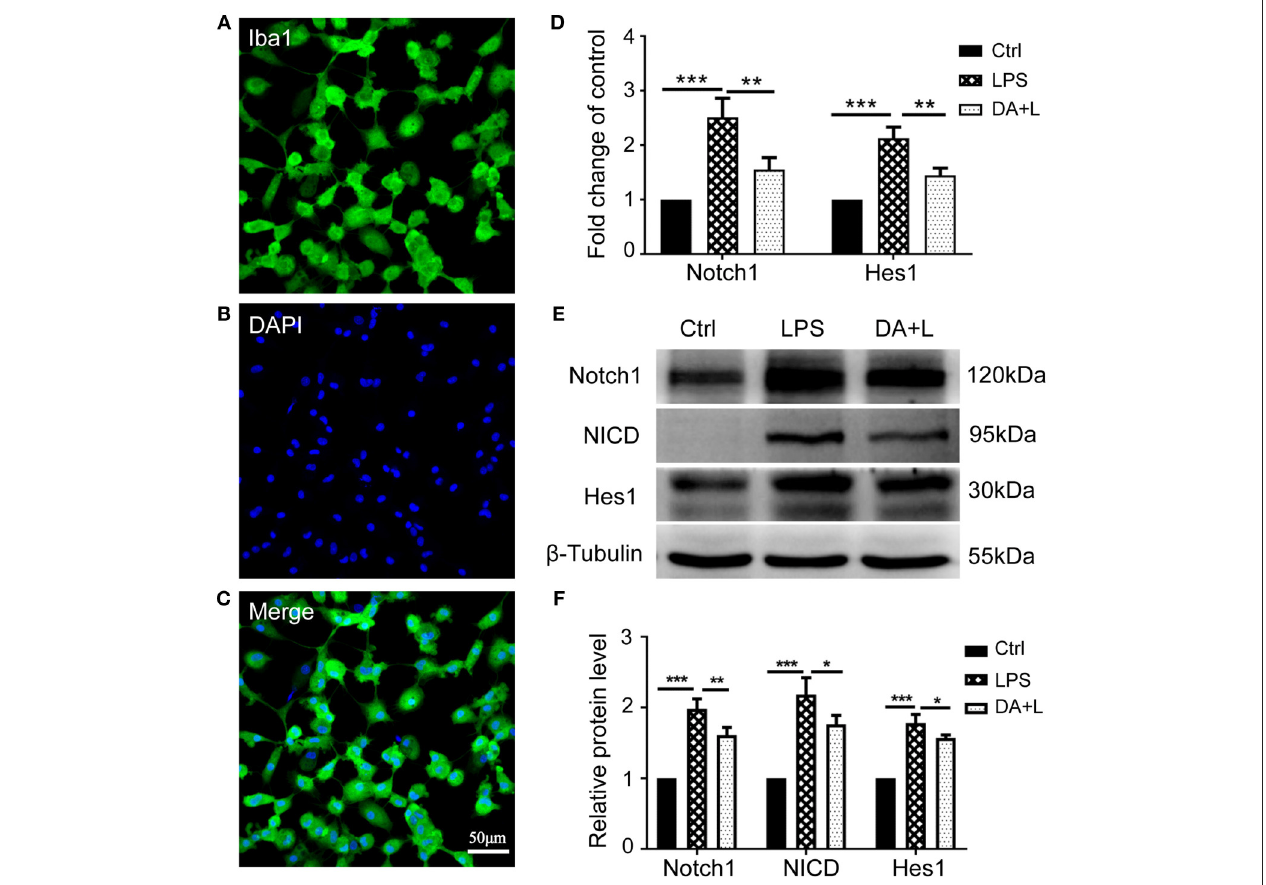
FIGURE 1 | Notch1 signaling was activated by LPS and inhibited by DAPT in primary cultured retinal microglia. (A–C) Confocal microscope images showed that more than 96% cultured cell were positively stained with Iba1 (green), and DAPI showing nuclei (blue). Scale bar, 50 µ m. (D) The mRNA expressions of Notch1 and Hes1 were significantly upregulated after LPS stimulation compared with the control. DAPT pretreatment reduced the increased expressions of Notch1 and Hes1 induced by LPS. (E,F) The protein expressions of Notch1 and Hes1 were consistent with the results of mRNA expression. In addition, DAPT treatment can suppress the increased protein expression of NICD induced by LPS. * p < 0.05, ** p < 0.01, and *** p < 0.001 (one-way ANOVA). Ctrl, Control; DA + L, DAPT + LPS.